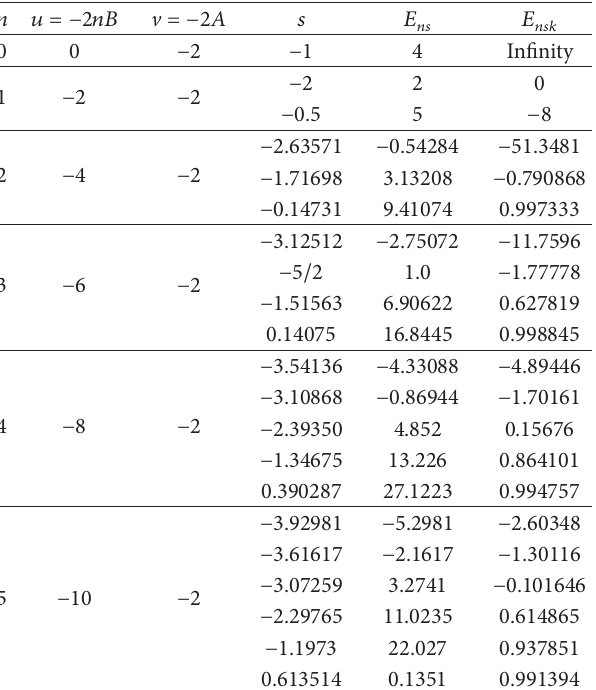
Table 1: Type 1 energy values when 𝐴 = 𝐵 = 1 . Table 2: Type 2 energy values when 𝐴 = 𝐵 = 1